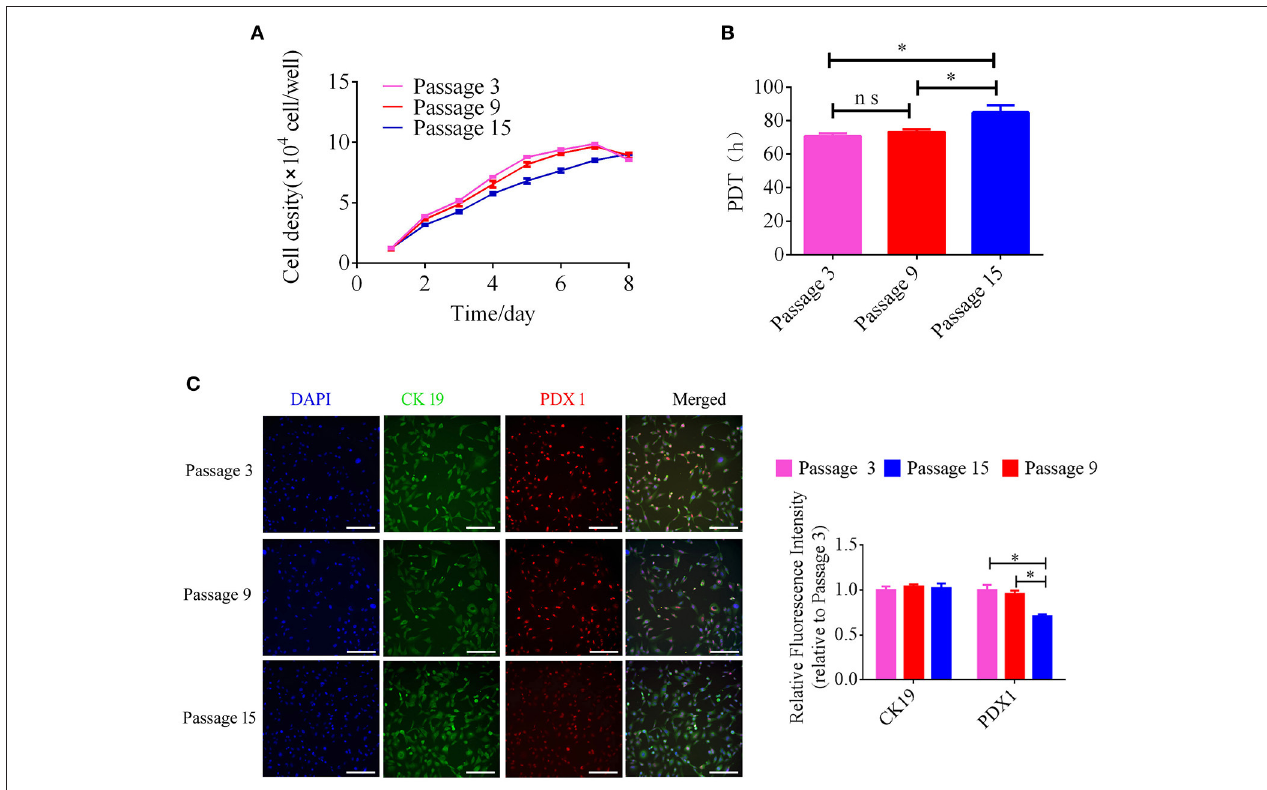
FIGURE 3 | Analysis of growth kinetics and specific makers in pancreatic ductal cells at Passage 3, 9, and 15. (A) Growth curves of pancreatic ductal cells cultured at passage 3, 9, and 15. Growth curves had a typical sigmoidal shape, indicating the latent, exponential growth, and stationary phases ( n = 3). (B) Analysis of population doubling time (PDT) in pancreatic ductal cells at passage 3, 9, and 15 ( n = 3). (C) Detection of CK19 and PDX1 by IF staining in pancreatic ductal cells at passage 3, 9, and 15, the expression level of PDX 1 was gradually down-regulated with the extended culture. * P < 0.05.